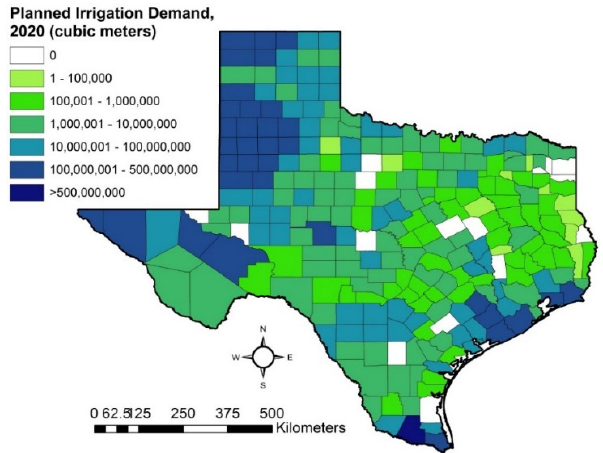
Figure 4. The irrigation water use in Texas by county is highest in in the northernmost part of the state (the Panhandle) and in the southernmost part of the state (the Lower Rio Grande River Basin). (Map created by the authors based on data from [22,37]).